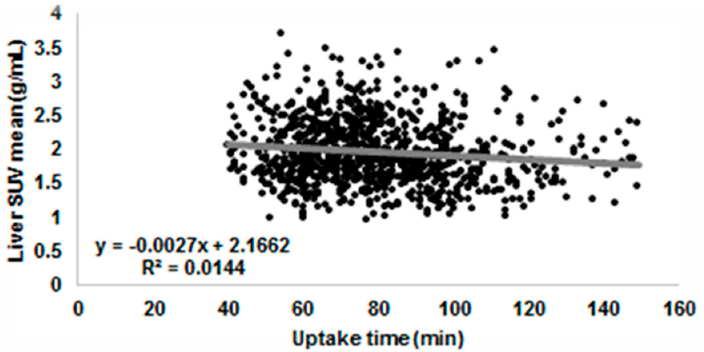
Figure 4. Histogram of uptake time in 1700 PET/CT scans acquired from over 56 PET sites across the world. The average uptake time is 79 ± 28 min (range 23–256).